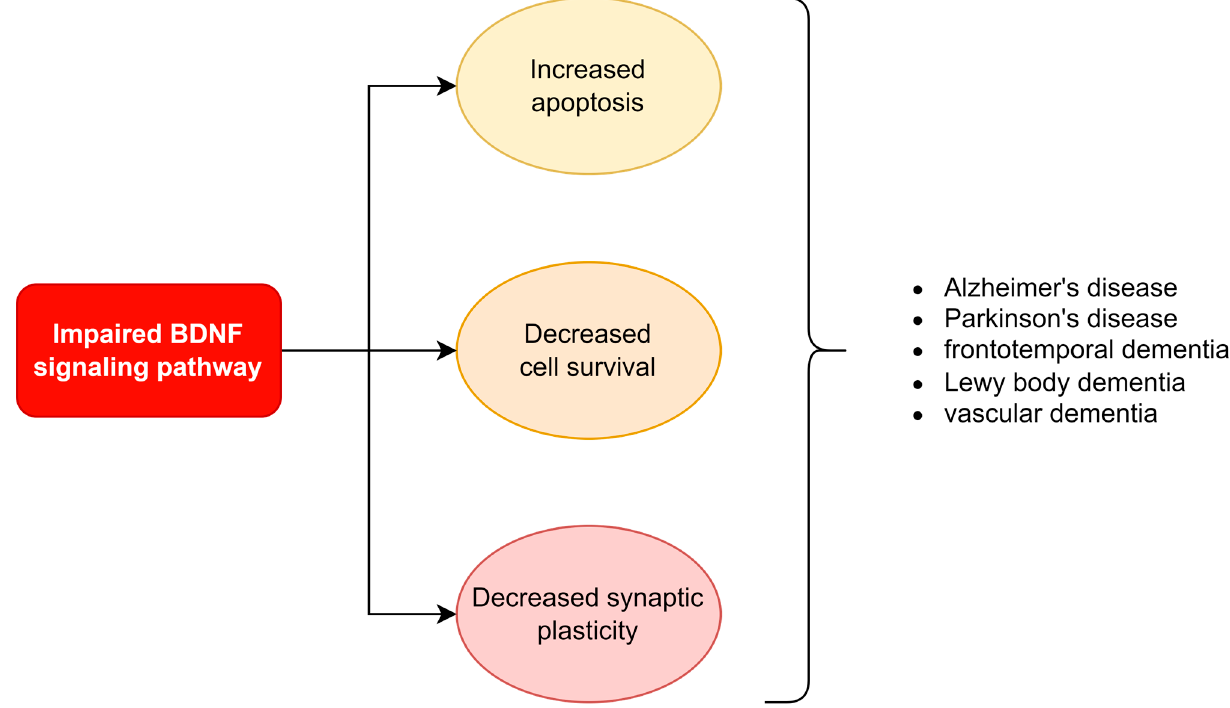
Figure 3. Summary of basic mechanisms through impaired signaling pathway involved in the development of chosen diseases.